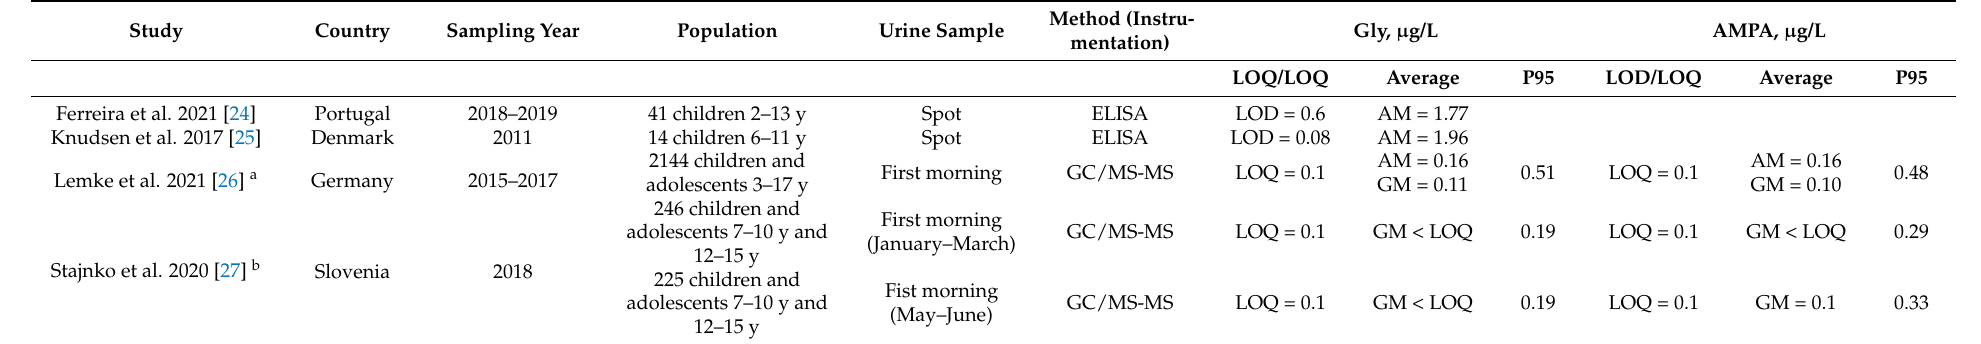
Table 3. Urinary Gly and AMPA concentrations in children reported in other European